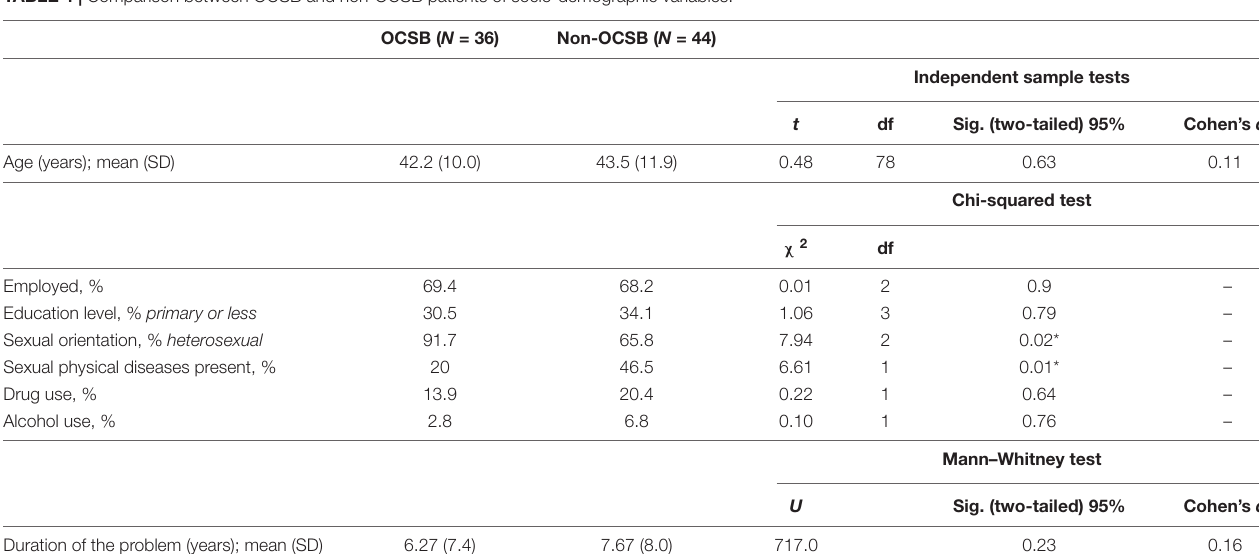
TABLE 4 | Comparison between OCSB and non-OCSB patients of socio-demographic